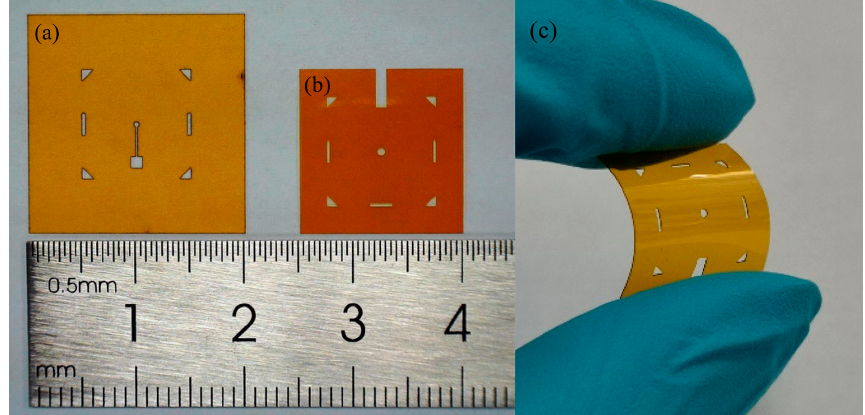
Figure 5. The optical image of commercial Kapton handled by laser precision machining system. ( a ) A 10 μ m thick Kapton tape used for printing mask; ( b ) a 100 μ m thick Kapton sheet served as a flexible substrate with a through-hole; ( c ) a flexible Kapton substrate. Sensors 2020 , 20 , x FOR PEER REVIEW